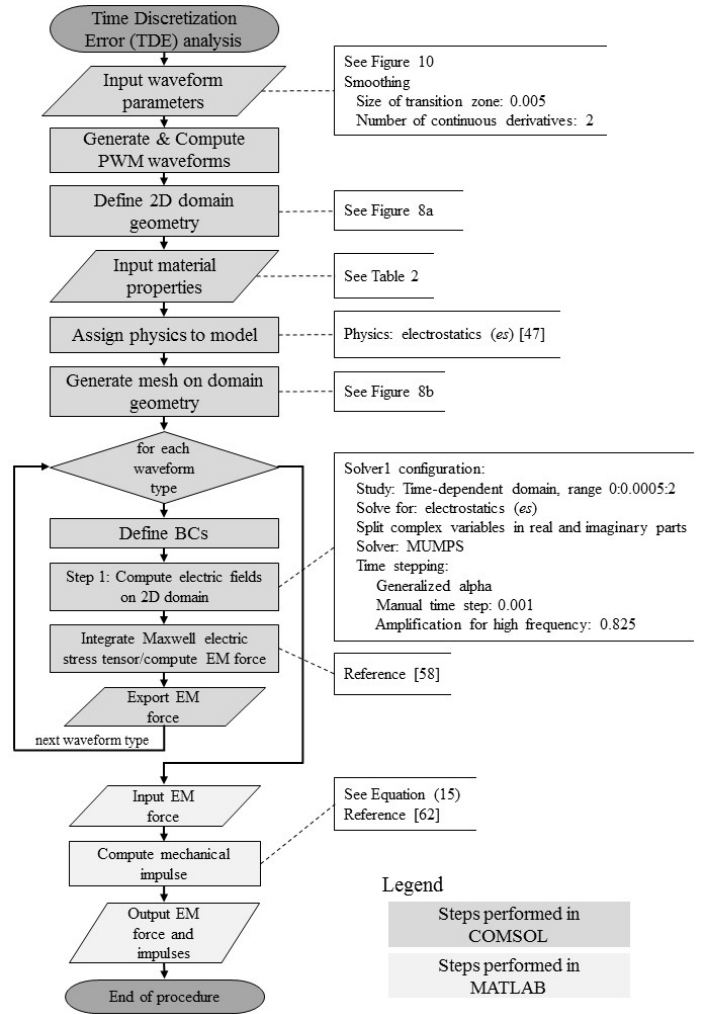
Figure 9. Time discretization error analysis flowchart.